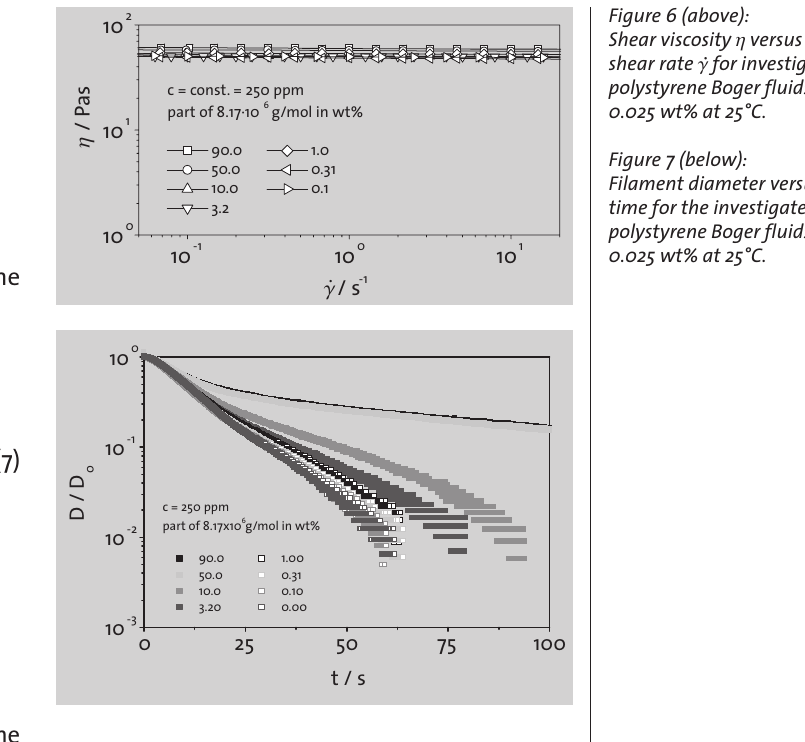
Figure 6 (above): Shear viscosity h versus shear rate g · for investigated polystyrene Boger fluids, 0.025 wt% at 25°C. Figure 7 (below): Filament diameter versus time for the investigated polystyrene Boger fluids, 0.025 wt% at